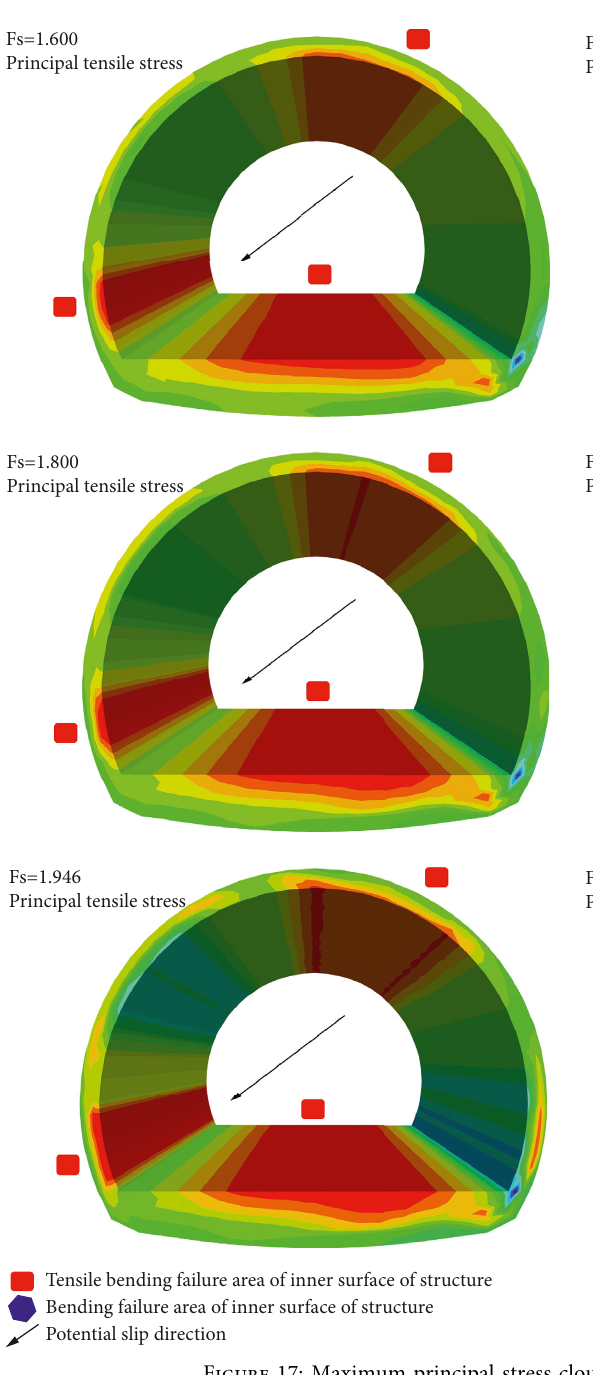
Figure 17: Maximum principal stress cloud diagram of the tunnel lining